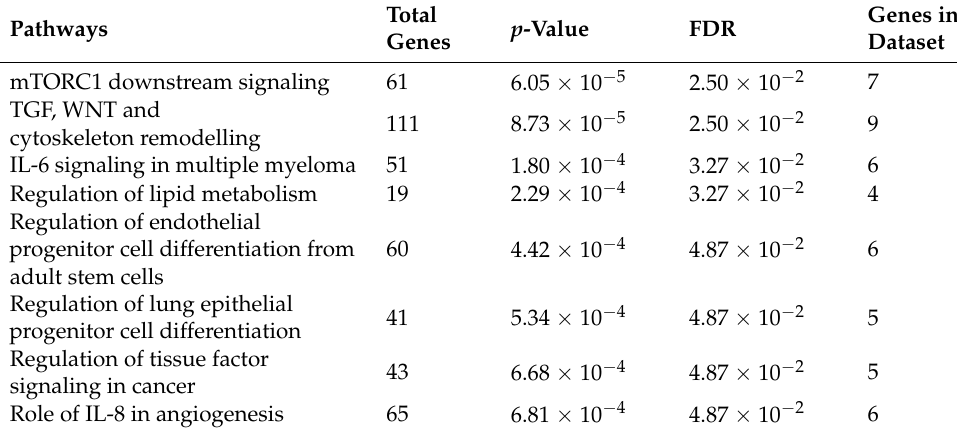
Table 1. The software MetaCore has been used to perform a pathway enrichment analysis on the DEGs after GPR17 silencing. Table shows the most significant pathways resulting from the analysis, the number of associated genes and of common genes included in the